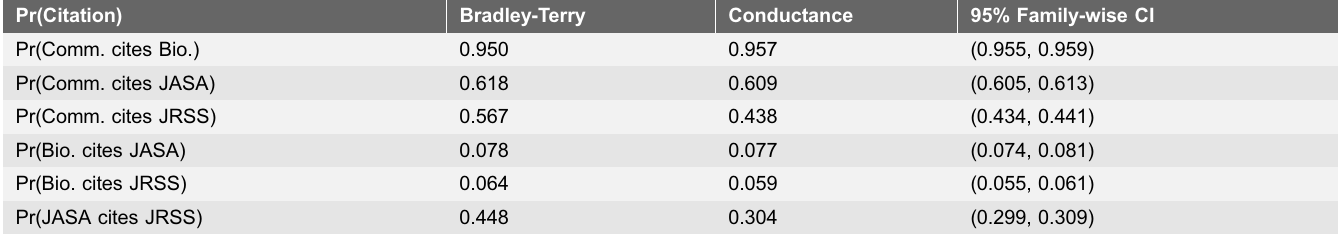
Table 2. Bradley-Terry and Conductance estimates for citation probabilities with Bonferonni adjusted 95% family confidence